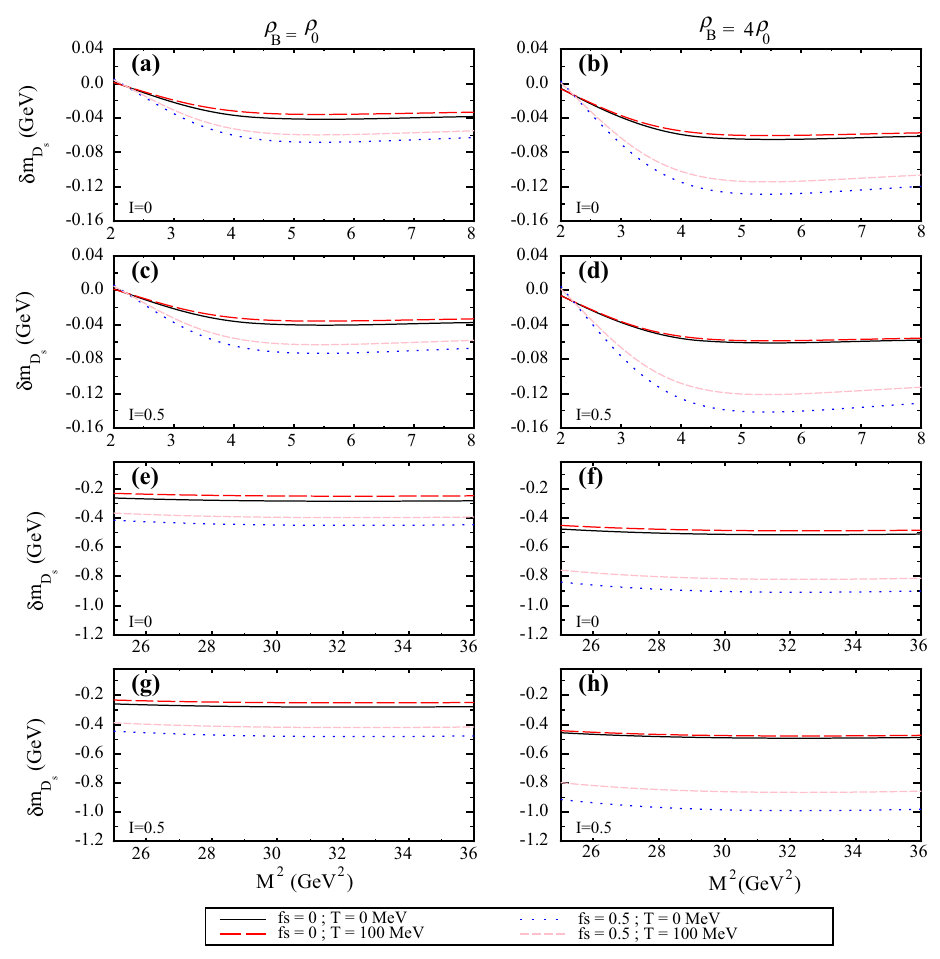
Fig. 1 The variation of the shift in the mass of pseudoscalar D s and B s mesons as a function of squared Borel mass parameter, M 2 for baryonic densities ρ 0 and 4 ρ 0 . The results are given for the isospin asymmetric